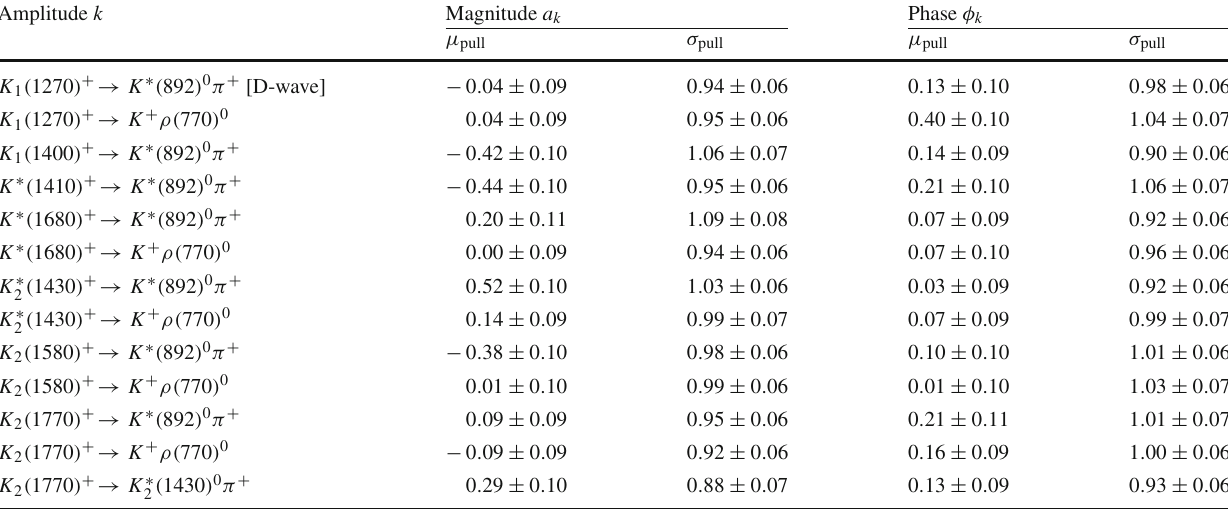
Table 3 Pull parameters of the fit to B + → K + π − π + γ samples for all magnitudes and phases relative to the amplitude with the S-wave decay K 1 ( 1270 ) + → K ∗ ( 892 ) 0 π + Amplitude